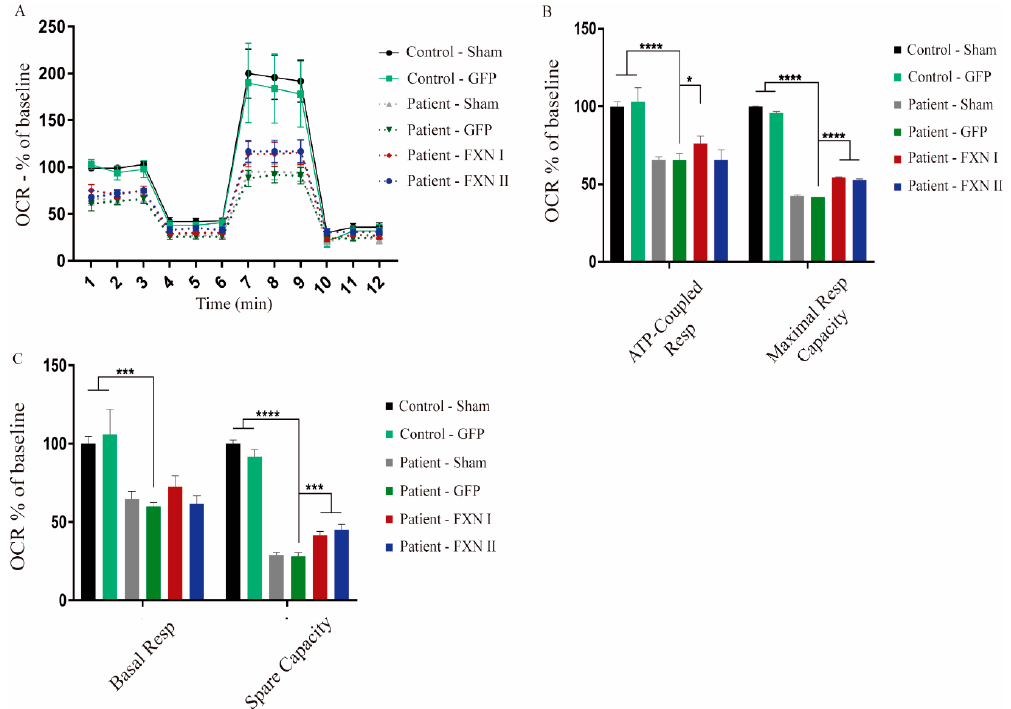
Figure 8. Seahorse assay in fibroblasts isolated from three FRDA patients and two healthy control subjects . ( A ) Representation of the oxygen consumption rate (OCR) in fibroblasts either non-transduced, or transduced with FXN I, FXN II or GFP as a positive transduction control. Patient cells transduced with frataxin isoforms seem to perform better on the assay, getting closer to the healthy cell OCR values. The X-axis plots different measurements over time (rates). ( B ) Relative quantification of the values of ATP-coupled respiration and of maximal respiratory capacity. Significant improvements in maximal respiratory capacity can be detected in patient fibroblasts after transduction with both frataxin isoforms. ( C ) Relative quantification of the values of basal respiratory capacity and spare capacity in both control and patient fibroblasts transduced with both isoforms. Data are represented as mean ± SEM and were analyzed with a one-way ANOVA with post hoc Dunnett multiple comparisons test from at least three independent experiments per cell line ( n = 3). * p < 0.05; *** p < 0.001; **** p <